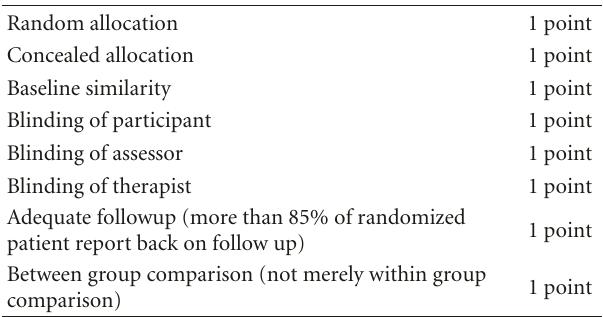
Table 5: PEDro scale criteria to assign scores to the RCT